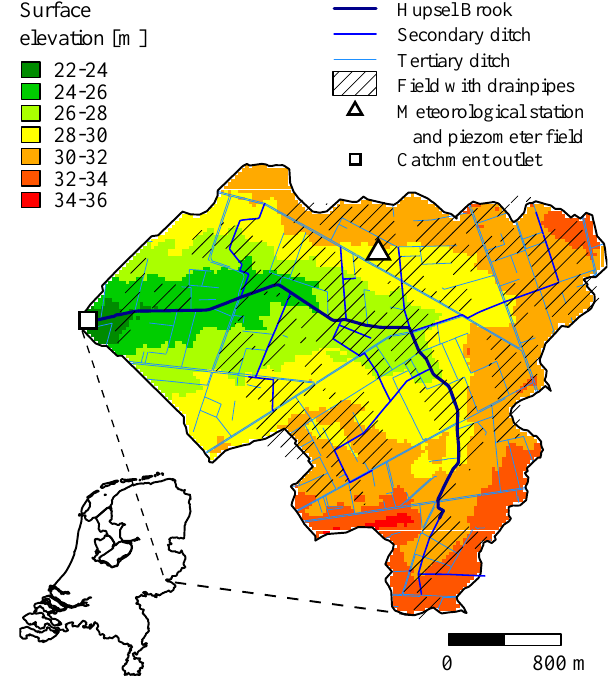
Fig. 1. Map of the Hupsel Brook catchment with the main hydro- logically relevant features (adapted from Van der Velde et al.,